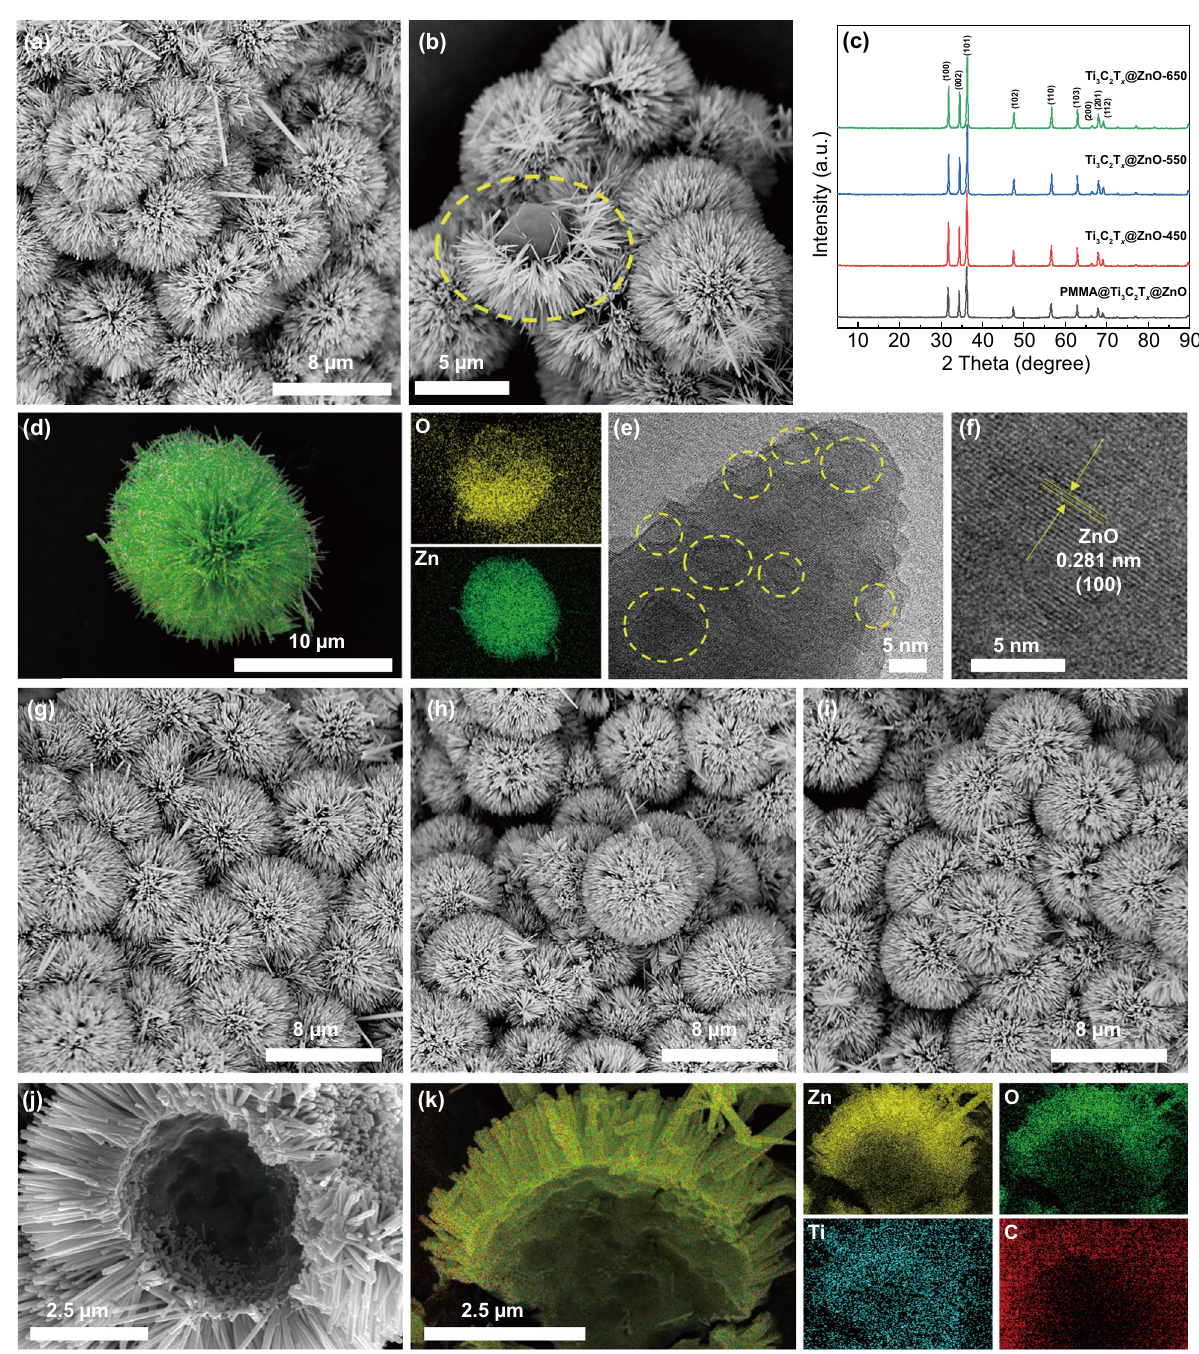
Fig. 2 a , b SEM images for PMMA@Ti 3 C 2 T x @ZnO and d the corresponding elemental Mapping; e , f high‑resolution TEM images for